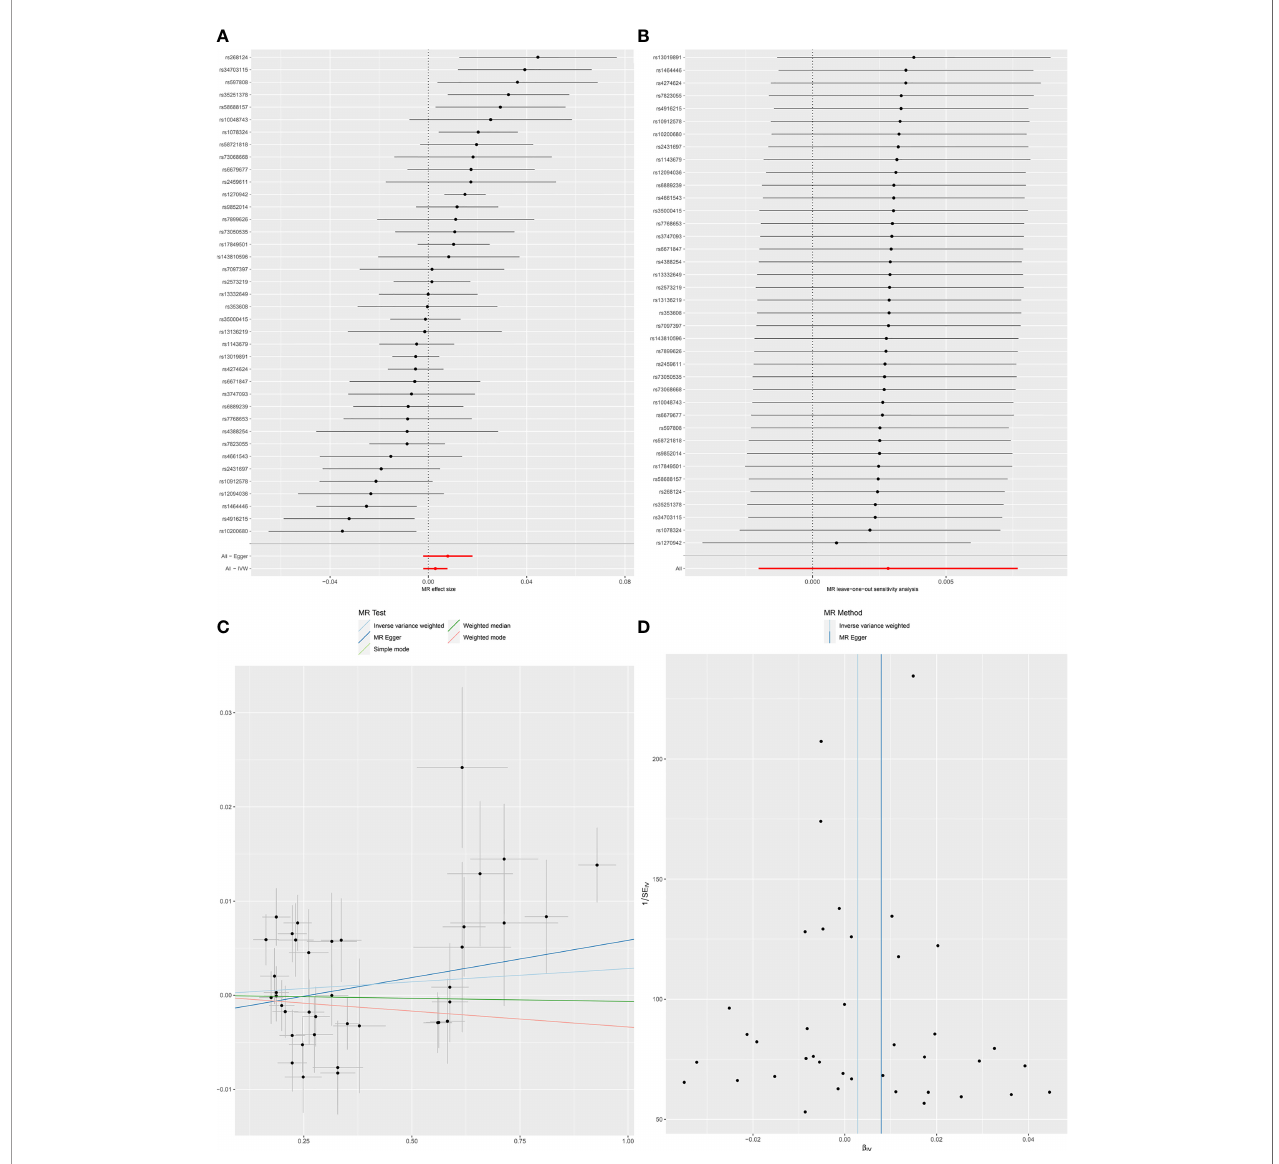
FIGURE 2 | Forest plot (A) , sensitivity analysis (B) , scatter plot (C) and funnel plot (D) of the causal effect of SLE on Chronotype